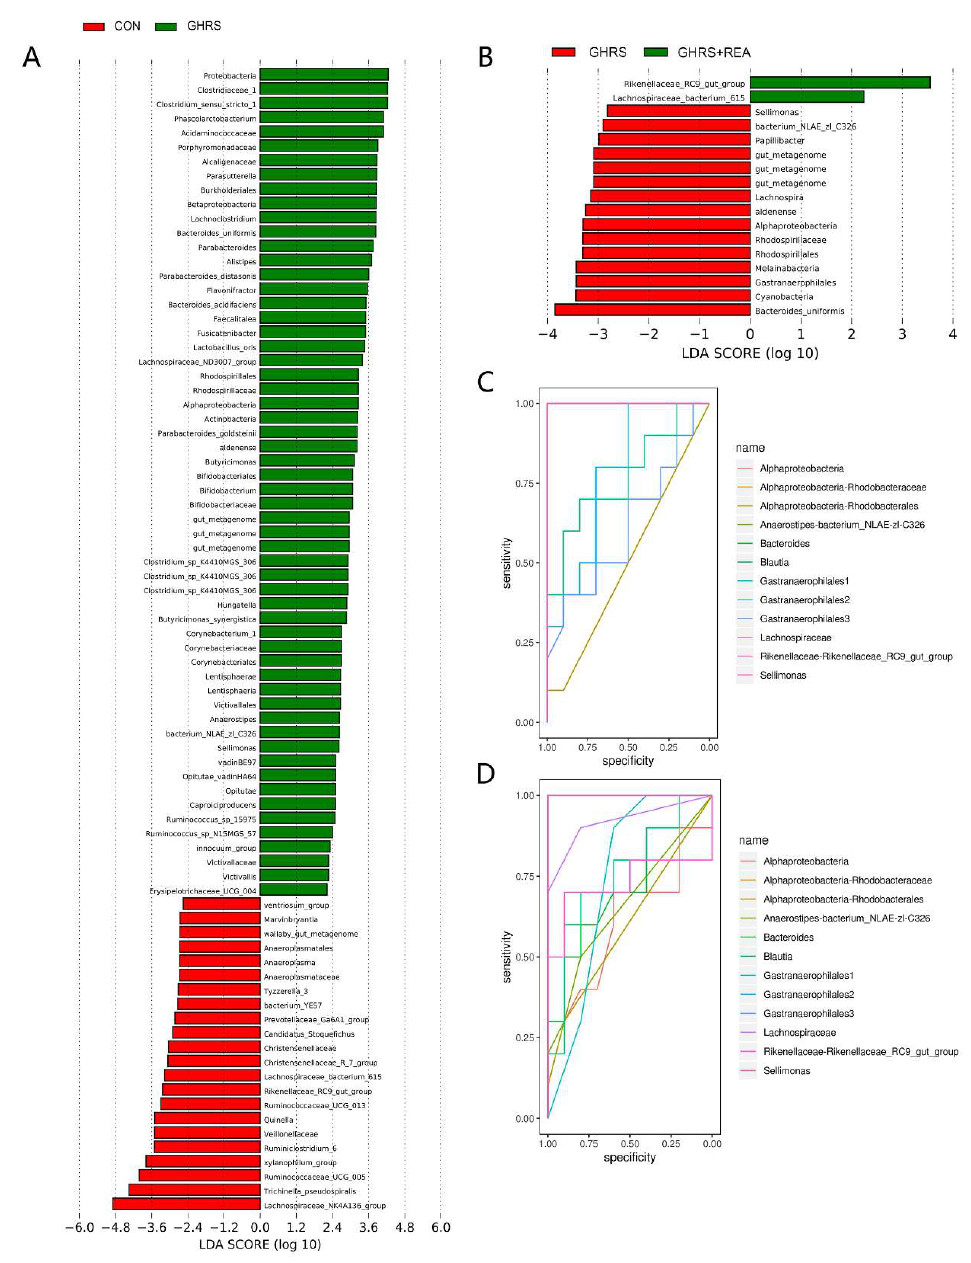
Figure 8. The microbial markers in the indicated groups. ( A ) Histogram showing LDA score for CON group and GHRS group. ( B ) Histogram showing LDA score for GHRS group and GHRS + REA group. ( C ) The ROC curve for CON group and GHRS group. ( D ) The ROC curve for GHRS group and GHRS + REA group.